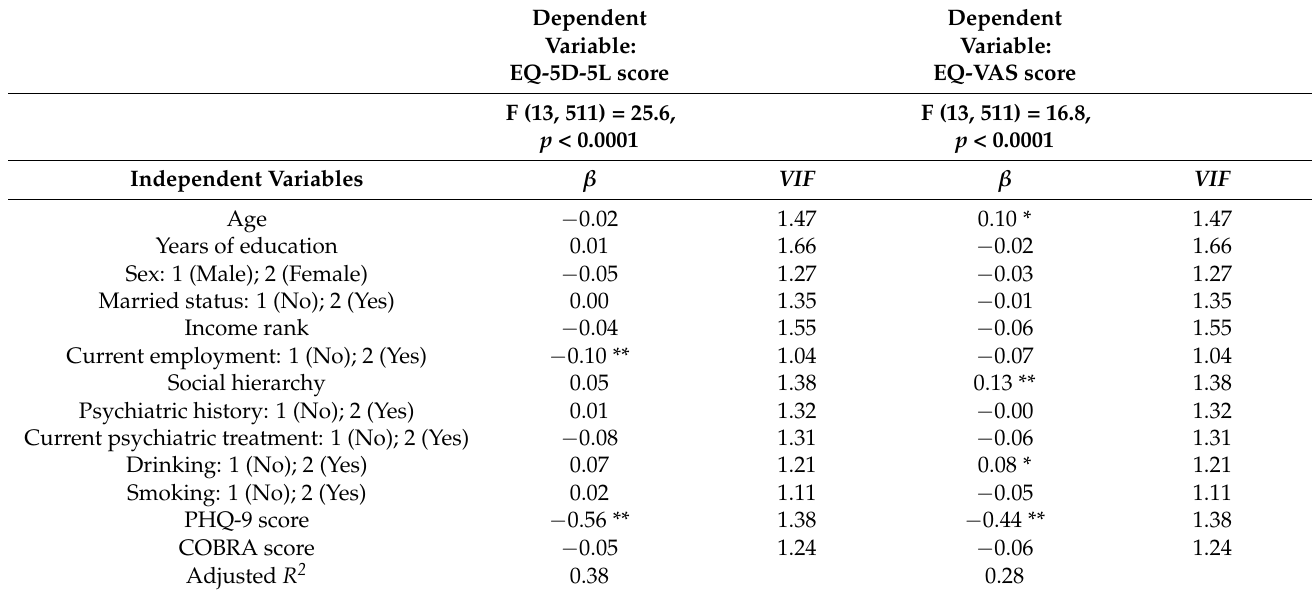
Table 3. Multiple regression analysis of HRQoL and perceived overall health ( n =